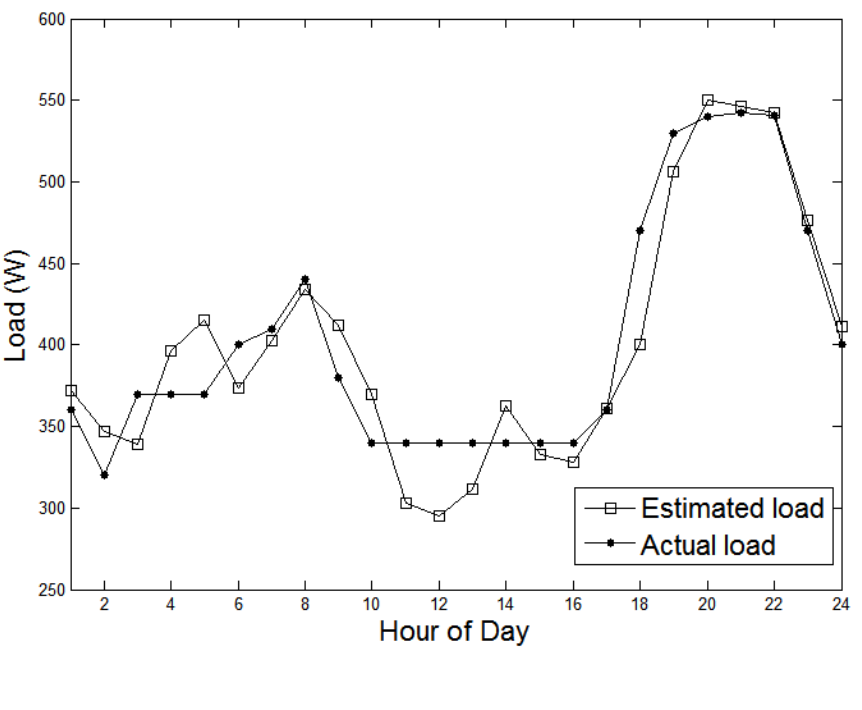
Figure 8. Actual and estimated load